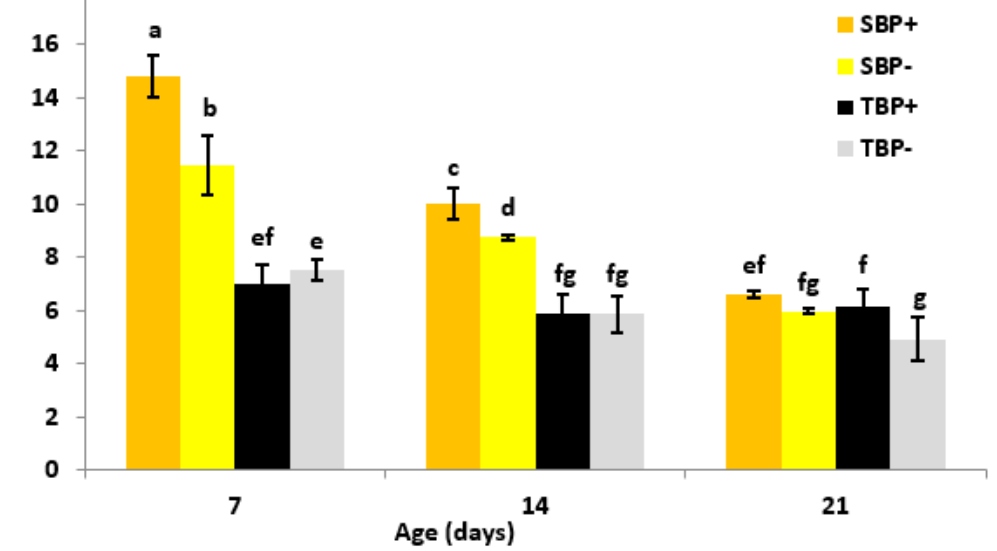
Figure 2. Mean ± SE acini surface area of the hypopharyngeal glands of both the subspecies of bees, at 7, 14 and 21 days. SBP+: A. mellifera sahariensis pollen-fed, SBP − : A. mellifera sahariensis pollen-deprived, TBP+: A. mellifera intermissa pollen-fed, TBP − : A. mellifera intermissa pollen-deprived. The error bars represent the standard deviation for the mean area of the hypopharyngeal glands. Bars with the same letter are not significantly different ( p < 0.05).